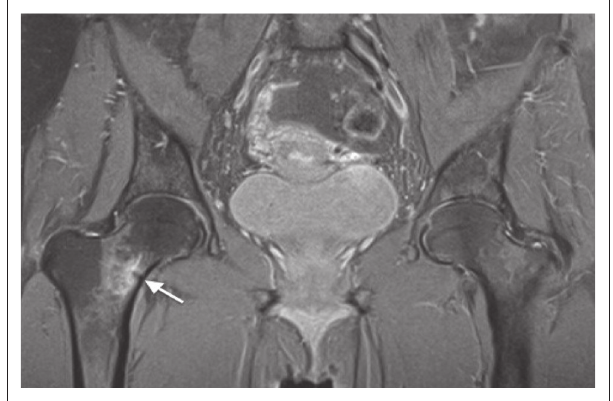
FIGURE 10: Stress fracture in a 38-year-old female runner with right groin pain. Coronal fat-saturated PD image demonstrates bone marrow oedema of the right femoral neck with an associated fracture (white arrow).